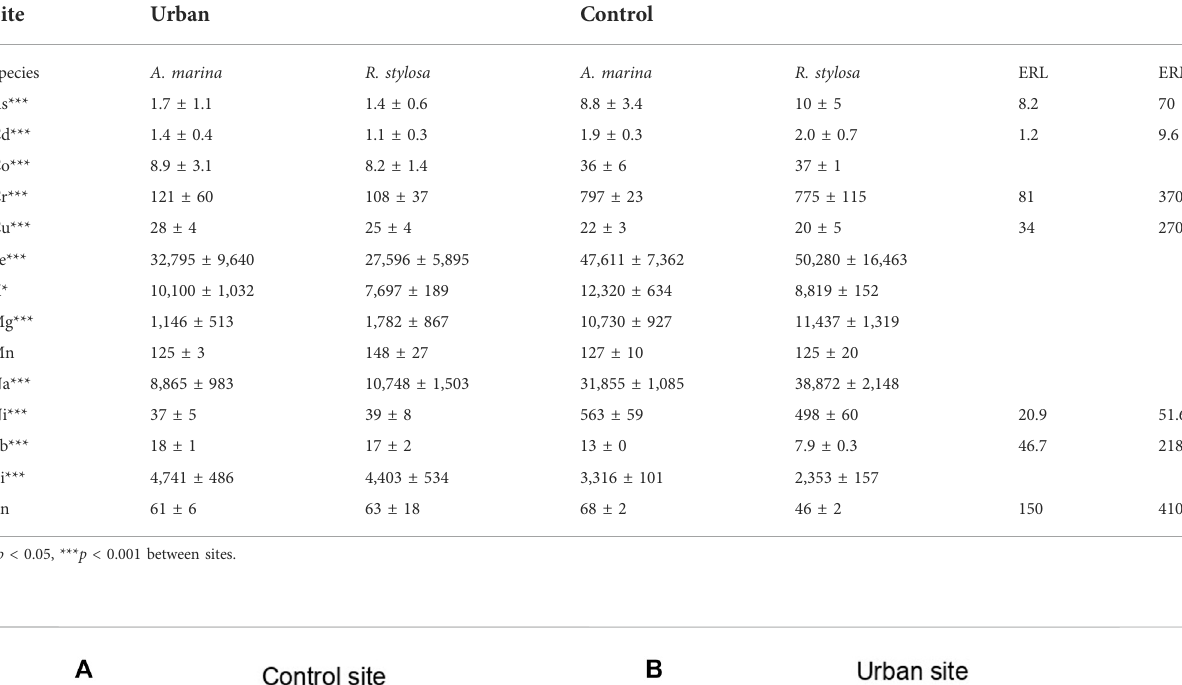
TABLE 1 Mean ± SD elemental total concentrations in soil (mg kg − 1 ) from both sites and under both mangrove species with signi fi cant differences displayed and Effect Range Low (ERL) and Effect Range Median (ERM) of TM in marine sediments from NOAA.